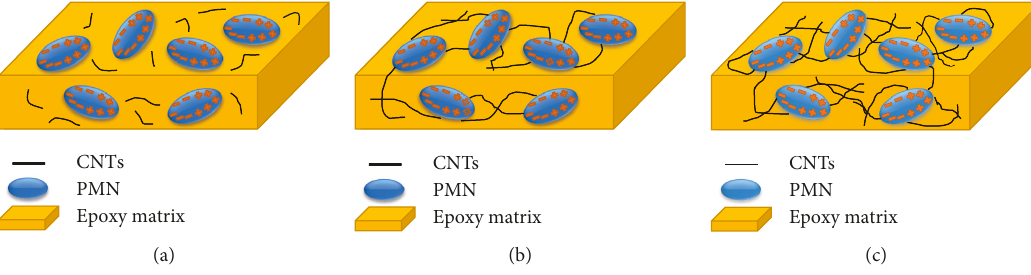
Figure 7: Formation status of CNT conductive network at different CNT contents.